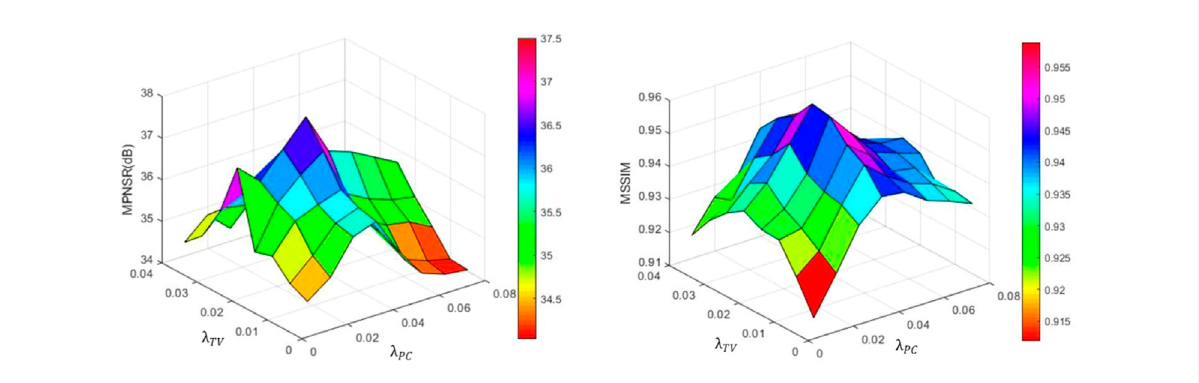
FIGURE 12 Sensitivity analysis of regularization parameter.